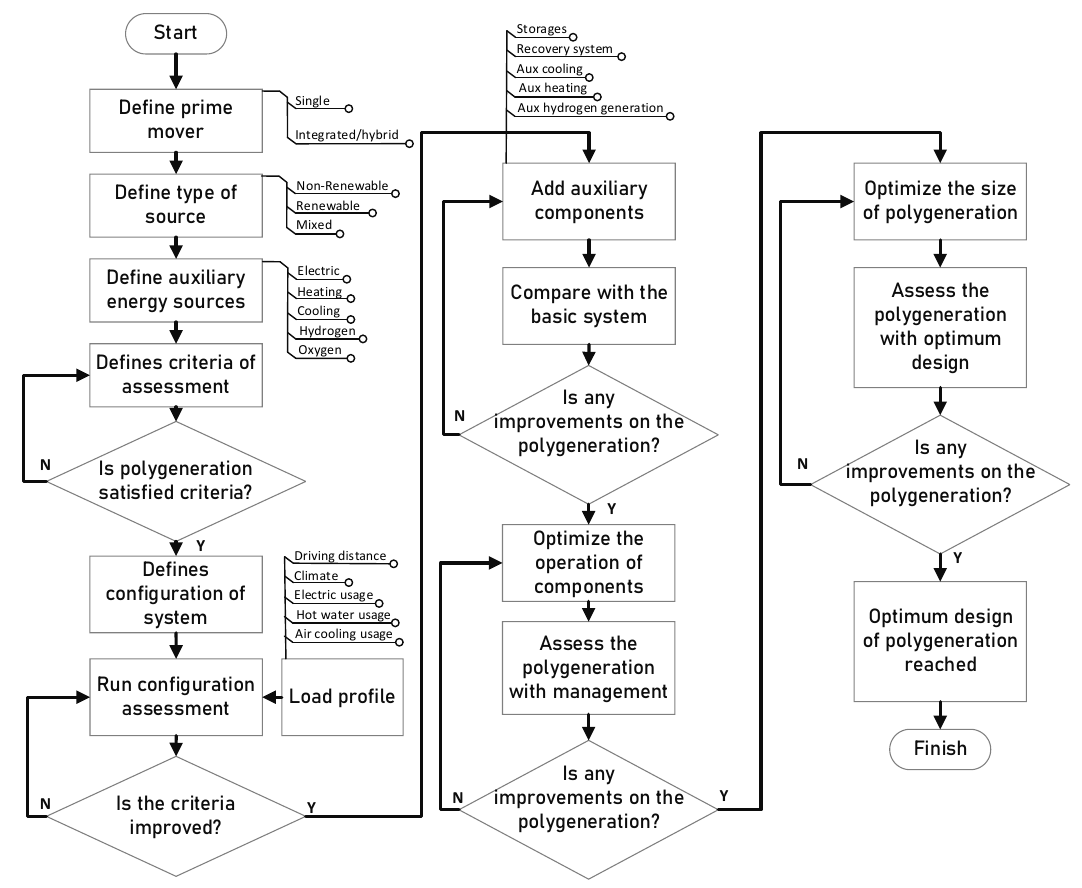
Figure 8. A flow chart of guidelines for optimizing a polygeneration system.